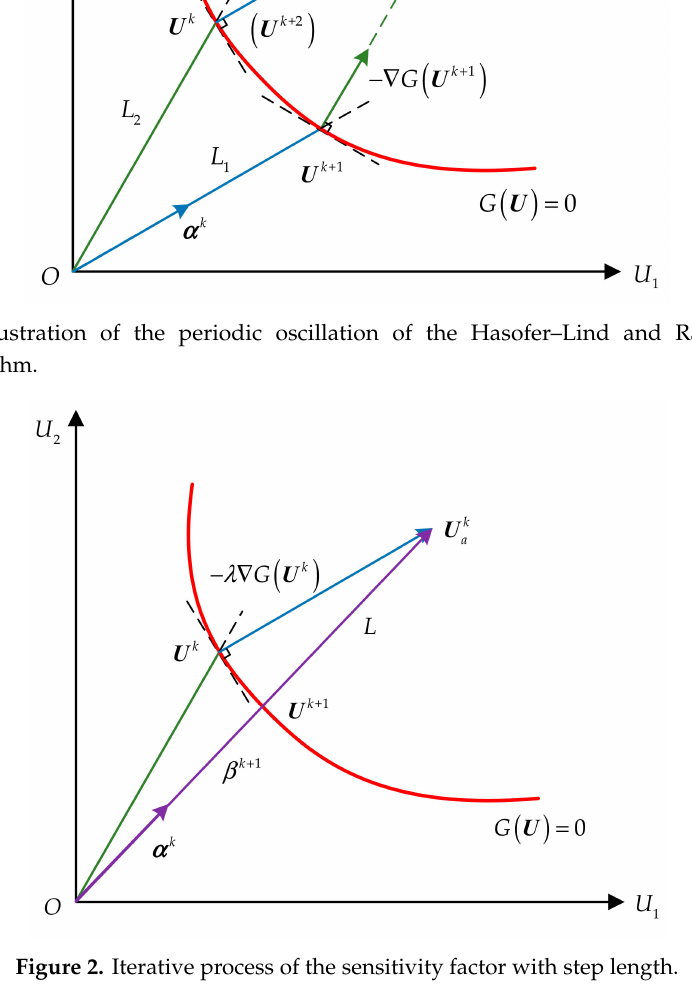
Figure 2. Iterative process of the sensitivity factor with step